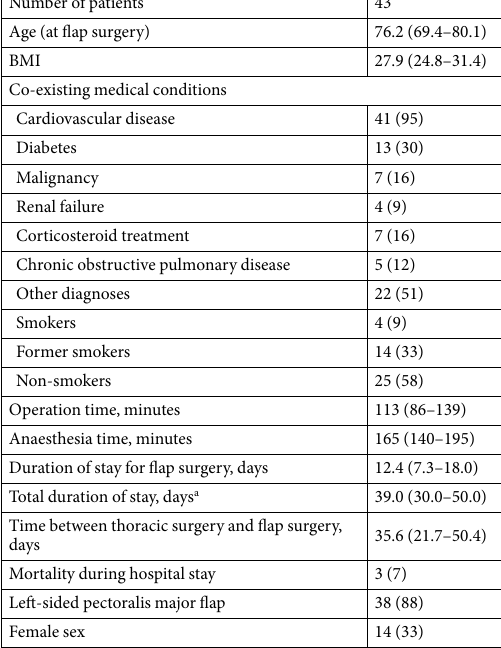
Table 1. Description of the patients. Data are presented as median (25–75 centile) or n (%). a Duration of stay during thoracic surgery and flap